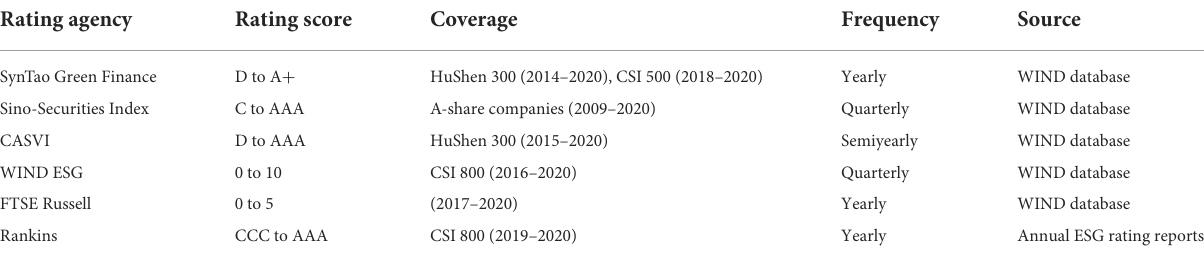
TABLE 1 Rating overview using available information in the